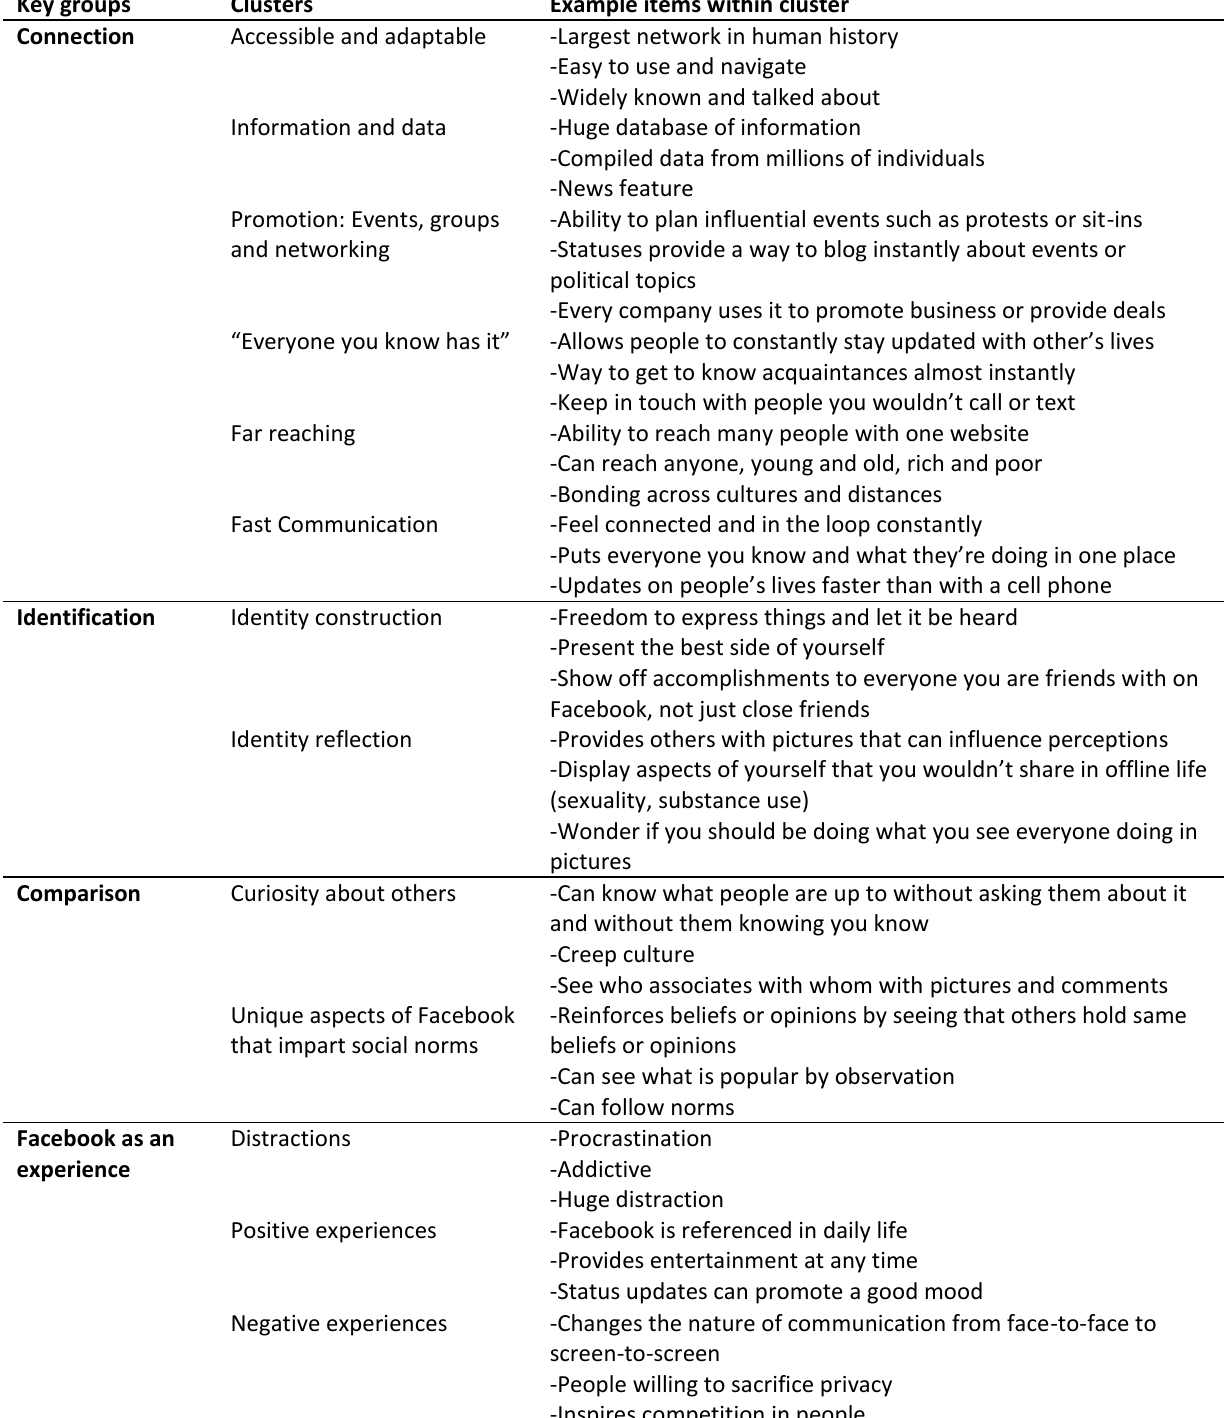
Table 1 . Clusters and concepts within the Facebook Influence Model. Key